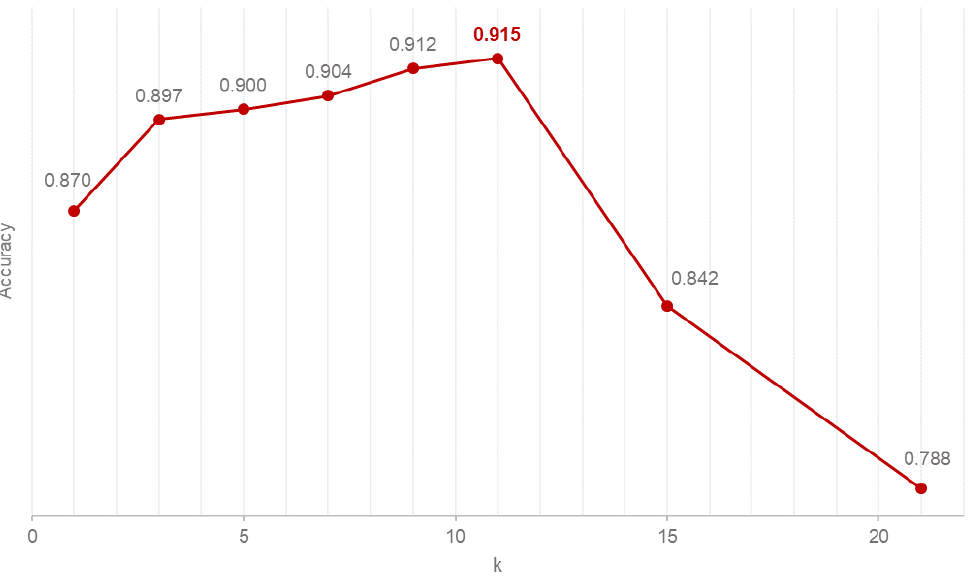
Figure 3. k -NN accuracy vs. k